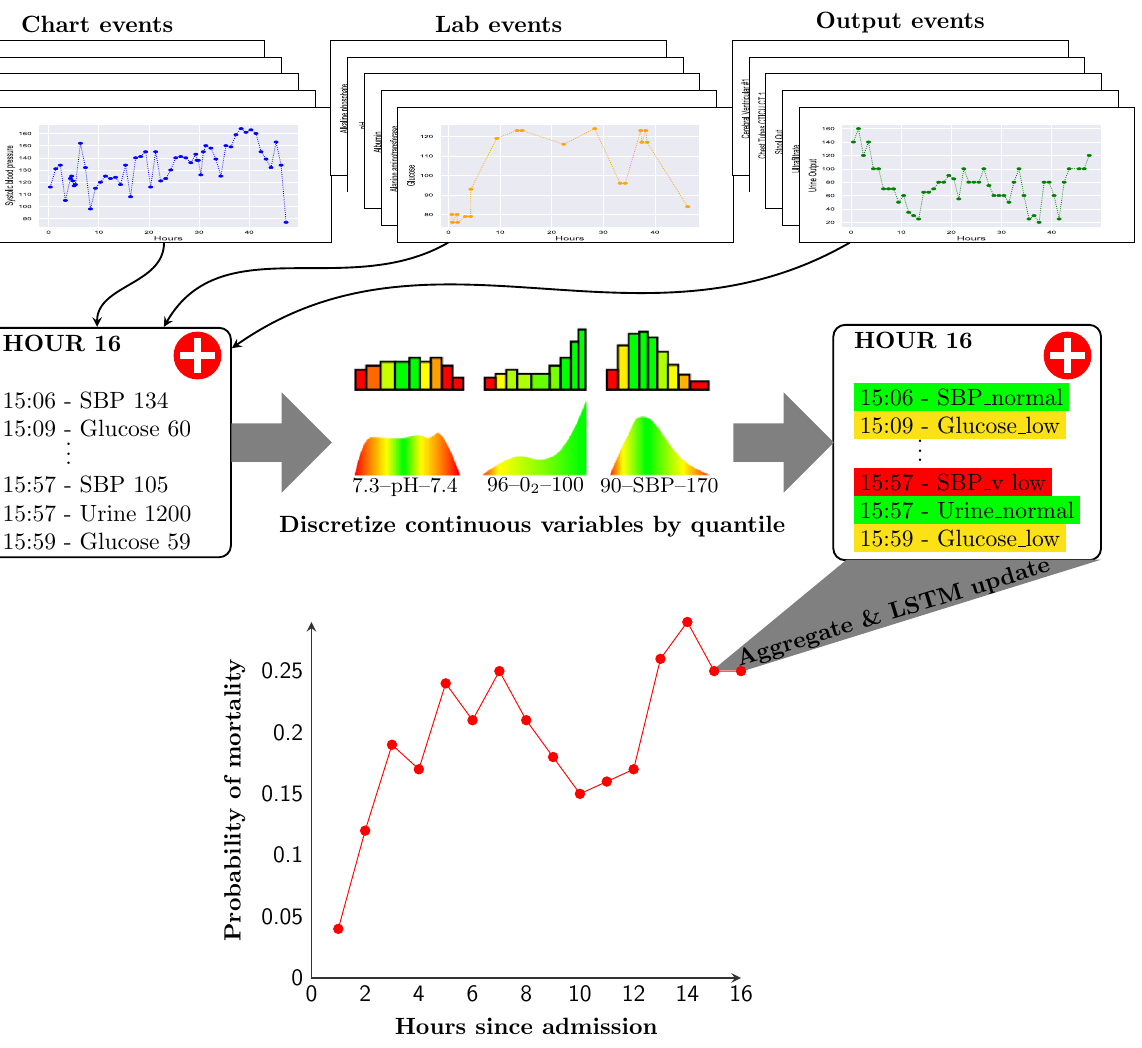
Figure 2. Diagram of our model. For each patient, all chart, lab, and output events are assembled into fixed time periods. Continuous data, such as Systolic Blood Pressure, Glucose, and Urine Output, are discretized into quantile-based bins, allowing continuous features to be mapped to an embedding. Discrete chart and lab events, from a diverse range of investigations, are equivalently aggregated by the model. Both continuous and discrete events from 1 h of patient timeseries data are embedded and aggregated, using a learnt variable importance ranking (colour in central distributions). The weighted average embedding is then used as input to a LSTM recurrent neural network which generates an updated dynamic prediction of in-hospital mortality probability each hour and updates an internal representation of the patient state. Dynamic prediction allows for continual patient monitoring as new data is accumulated and used to update outcome probabilities. Laboratory values, physiological readings, and admission information was from the first 48 h after ICU admission. LSTM long short-term